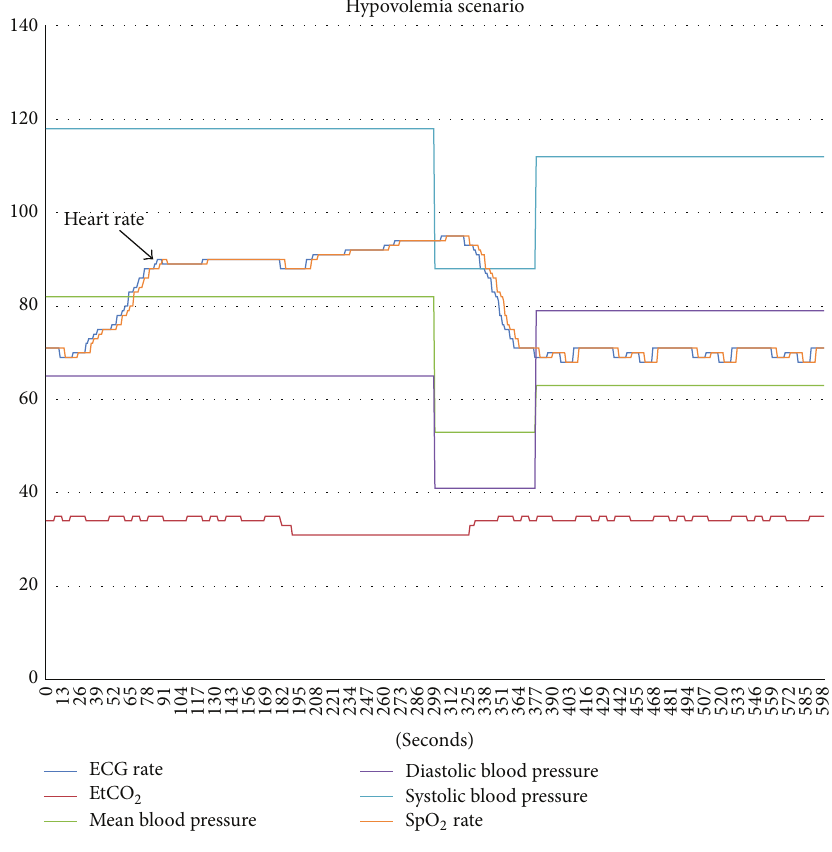
Figure 3: Plot showing the changes to relevant parameters in the “hypovolemia” scenario. Near the beginning, heart rate gradually increases over 5 minutes but does not surpass the alarm threshold. Later in the scenario, a low blood pressure is measured and the appropriate alarm sound enunciated. All parameters normalize and revert back to baseline levels before the end of the